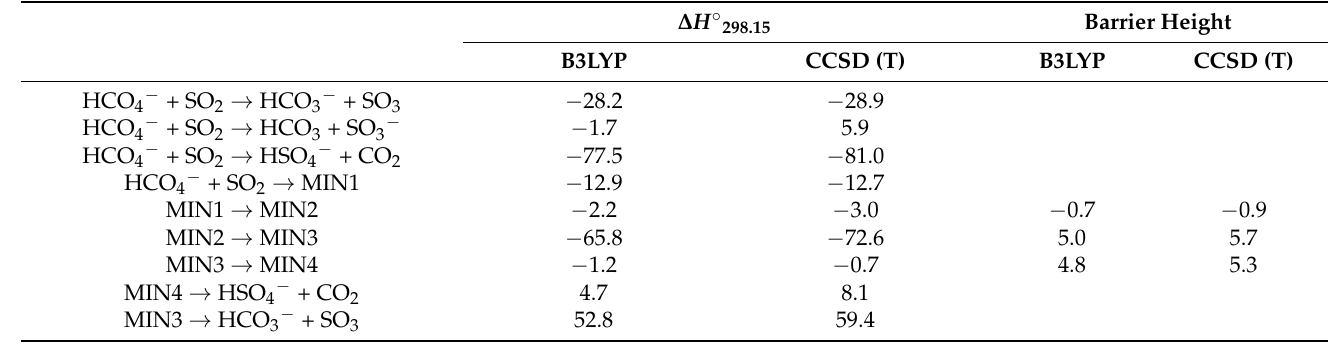
Figure 5. Charge density distributions of the minima and transition states localised on [HCO 4 ∙∙∙ SO 2 ] − potential energy surfaces computed at the CCSD(T)/aug-cc-pV(T+d)Z level of theory. Table 2. Enthalpy changes (kcal mol − 1 , 298.15 K) computed at the B3LYP/aug-cc-pV(T+d)Z